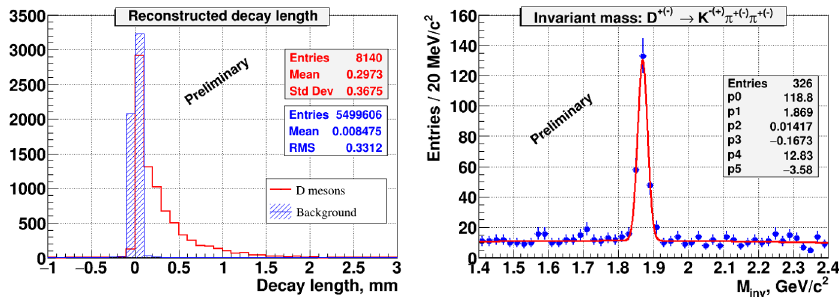
√ Figure 7. D-meson selection in pp-collisions at s = 25 GeV: left) reconstructed in ITS decay length of D + ( − ) -mesons from decays to K − ( + ) π + ( − ) π + ( − ) and background combinations; right) reconstructed invari- ant mass of K − ( + ) π + ( − ) π + ( − )